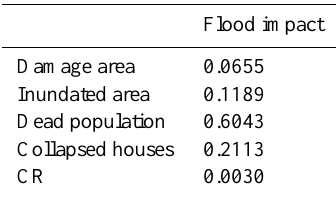
Table 4. Vector of weights of the alternatives with respect to flood disasters.